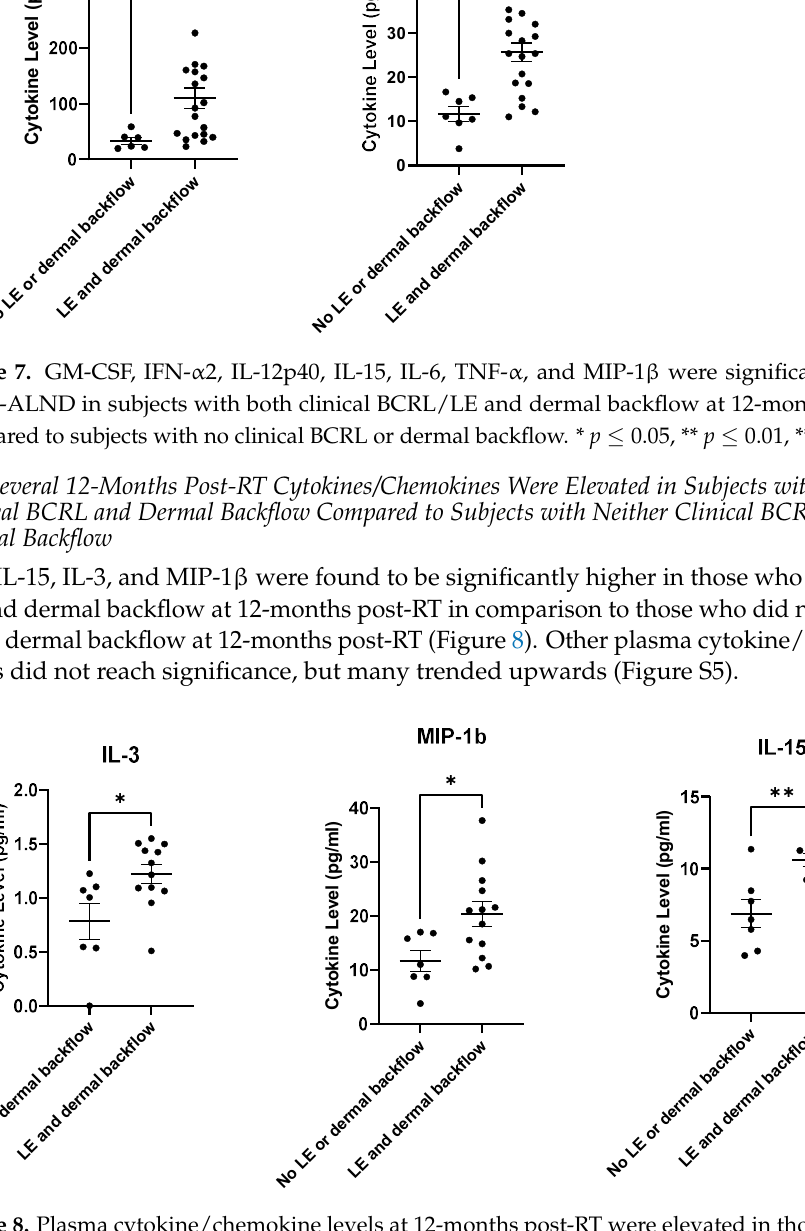
Figure 8. Plasma cytokine/chemokine levels at 12-months post-RT were elevated in those who had